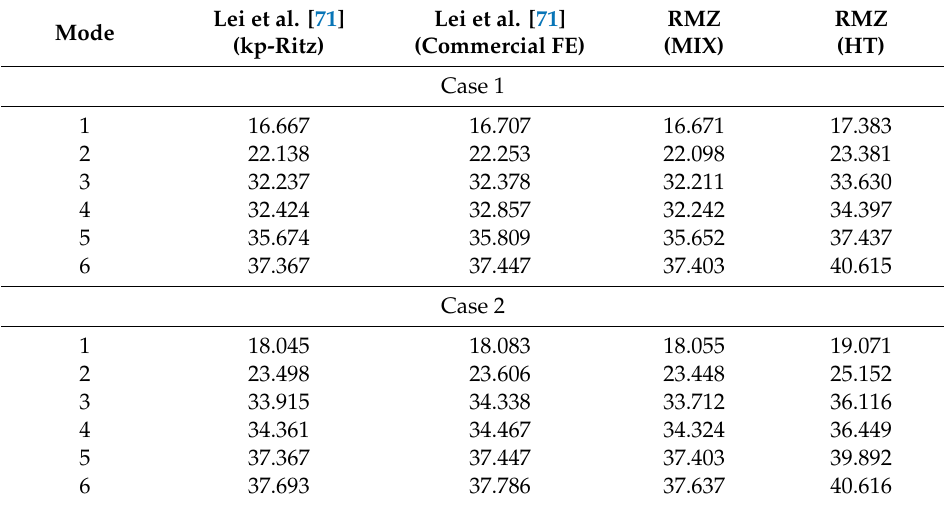
Table 4. Comparison of the frequency parameter (cid:36) for a two phase fully clamped